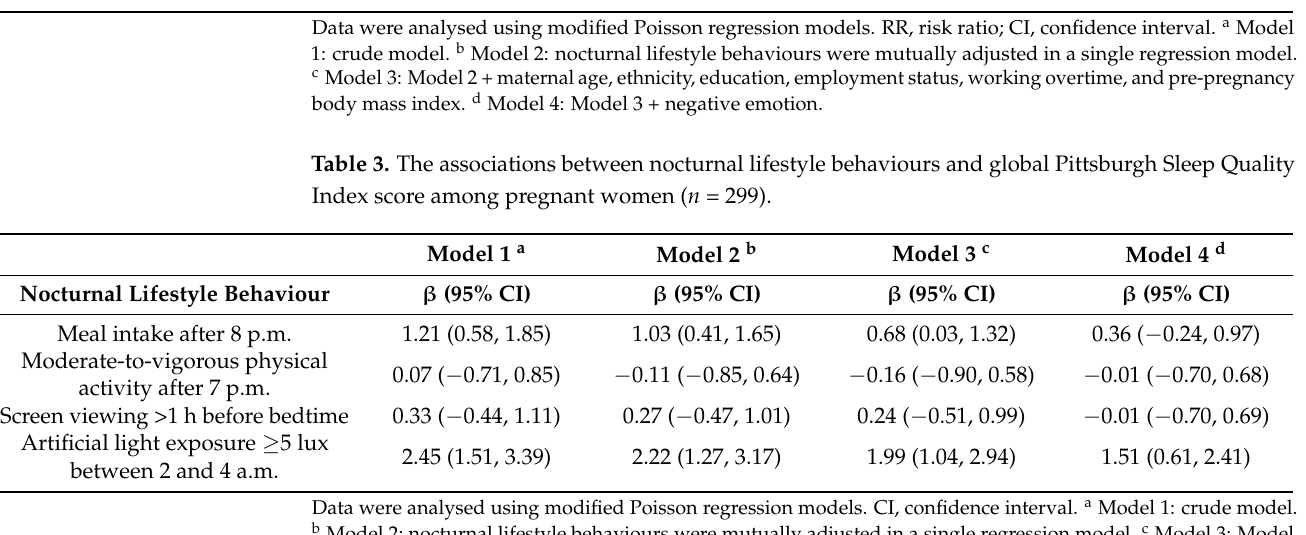
Model 2: nocturnal lifestyle behaviours were mutually adjusted in a single regression model. c Model 3: Model 2 + maternal age, ethnicity, education, employment status, working overtime, and pre-pregnancy body mass index. d Model 4: Model 3 + negative